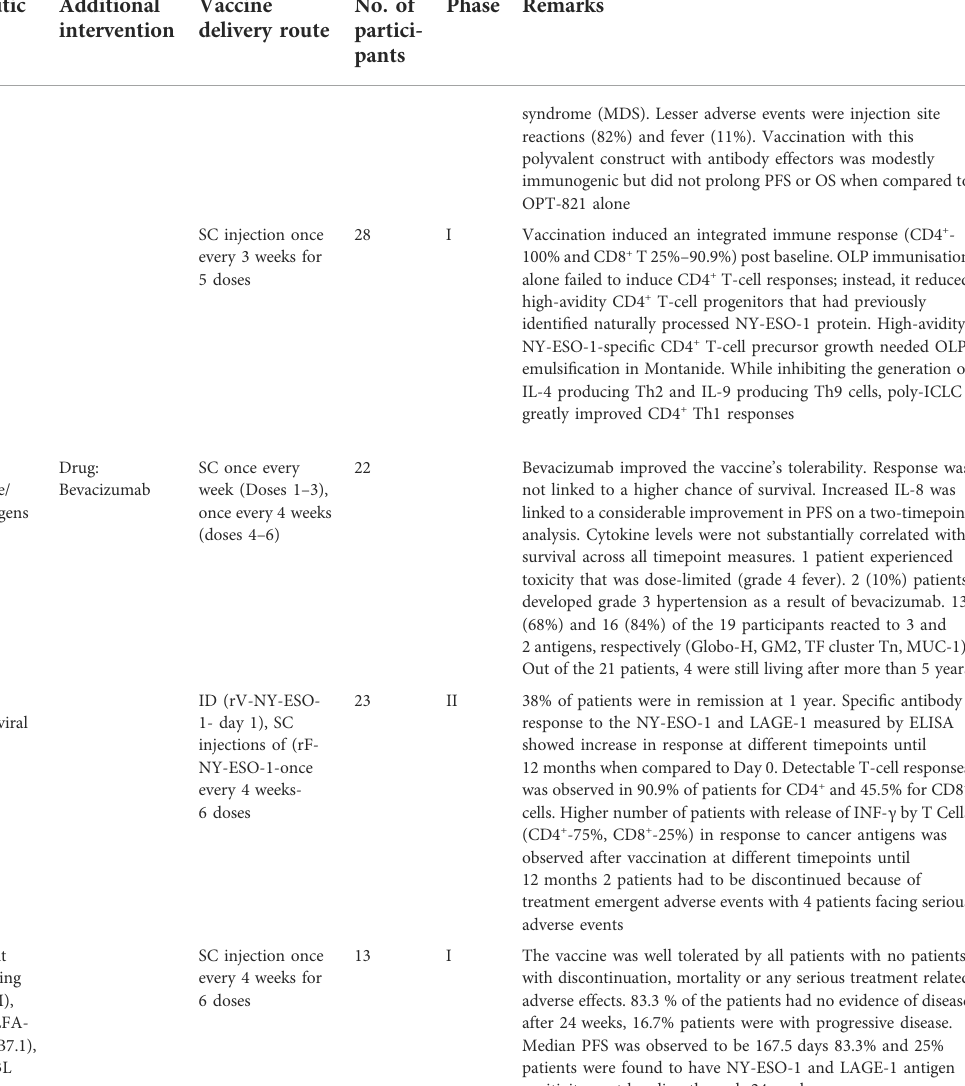
TABLE 2 ( Continued ) Table of completed clinical trials showing promising results for various cancer vaccines in OC. All of these vaccines have been used as a second line of treatment after initial cytoreductive debulking of the primary tumours and